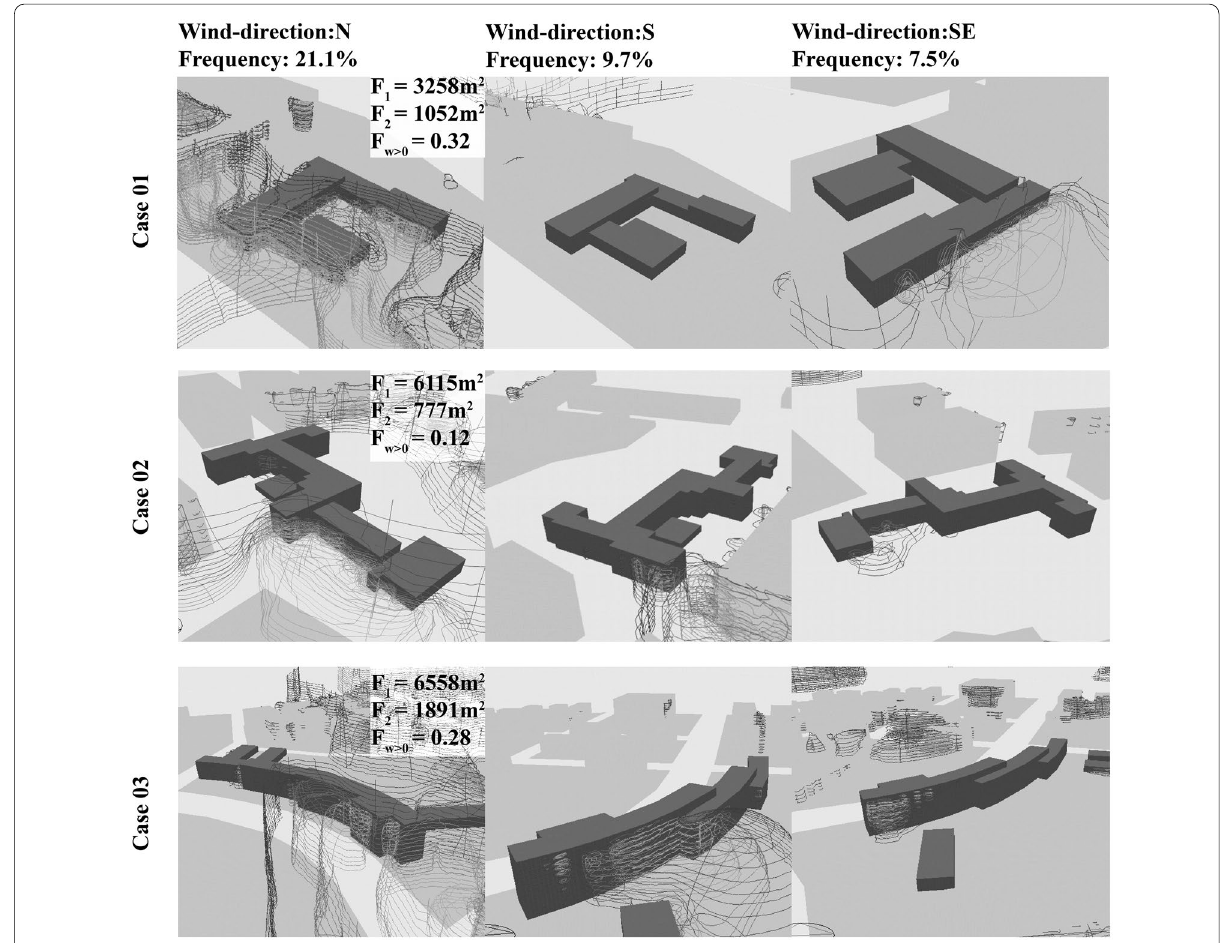
Fig. 4 Wind form index (F w>0 ). Comparative 3D critical building